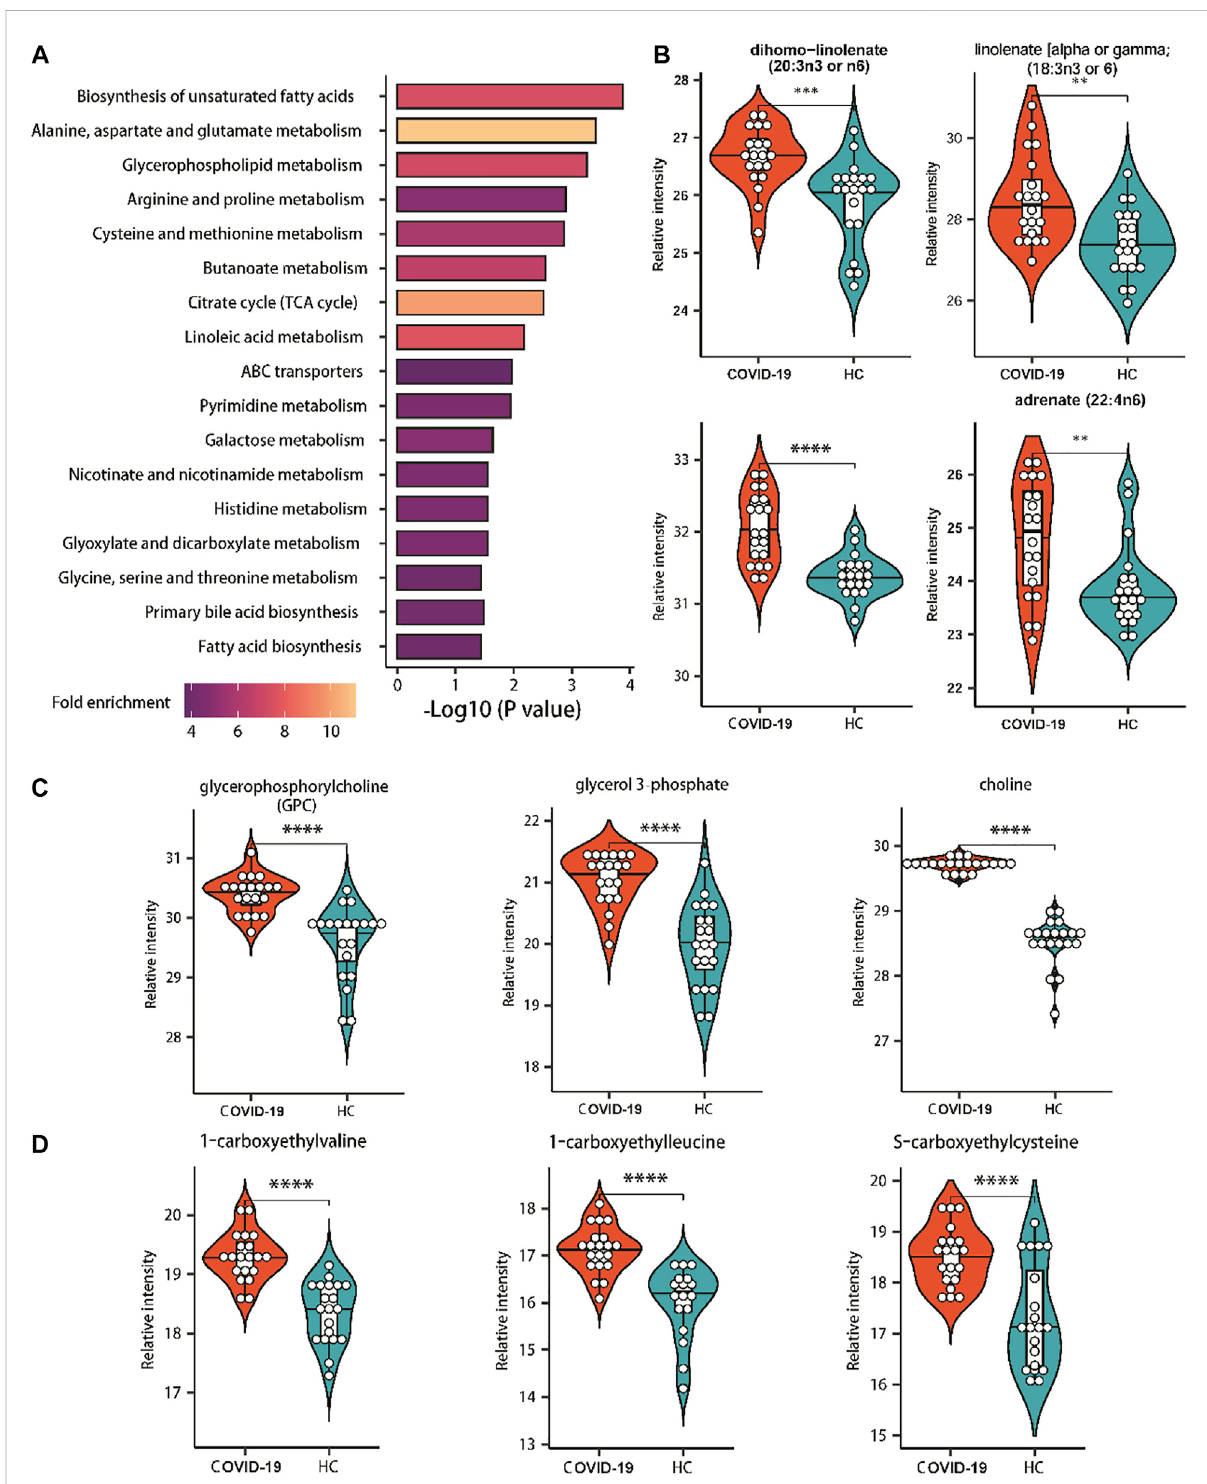
FIGURE 4 Enriched pathways of signi fi cantly altered metabolites of COVID-19 patients. (A) Metabolic pathways enriched based on metabolites consistently increased or decreased in COVID patients compared with healthy controls. Fold enrichment is represented by color intensity. One- sided Fisher ’ s exact test followed by BH multiple comparison test. (B) Relative abundance of metabolites involved in the biosynthesis of unsaturated fatty acids. (C) Relative abundance of metabolites involved in the glycerophospholipid metabolism. (D) Relative abundance of metabolites involved in the amino acids metabolism. p , p -value < 0.05 pp , p -value < 0.01; ppp , p -value < 0.001; pppp , p -value <